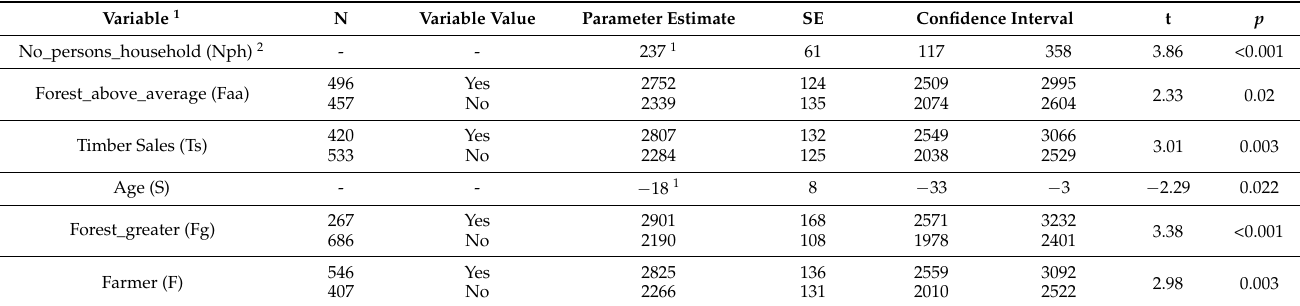
Table 7. Results of multiple regression analysis of response variable WTA4 on explanatory variables (variable values: 1, yes; 0, no; parameter estimate: expected value of WTA4) in research conducted in April 2019 on a random representative nationwide sample of forest owners (farmers). SE, standard